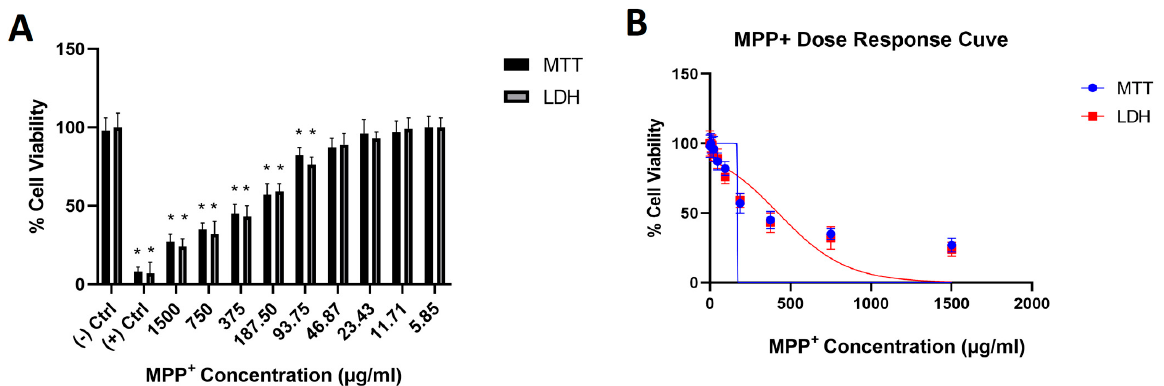
Figure 8. ( A )—Cell viability of differentiated SHSY-5Y cells treated with MPP+ (24 h) is presented. ( B )—Dose–response curve when the cell culture was treated with MPP+ in various concentrations.